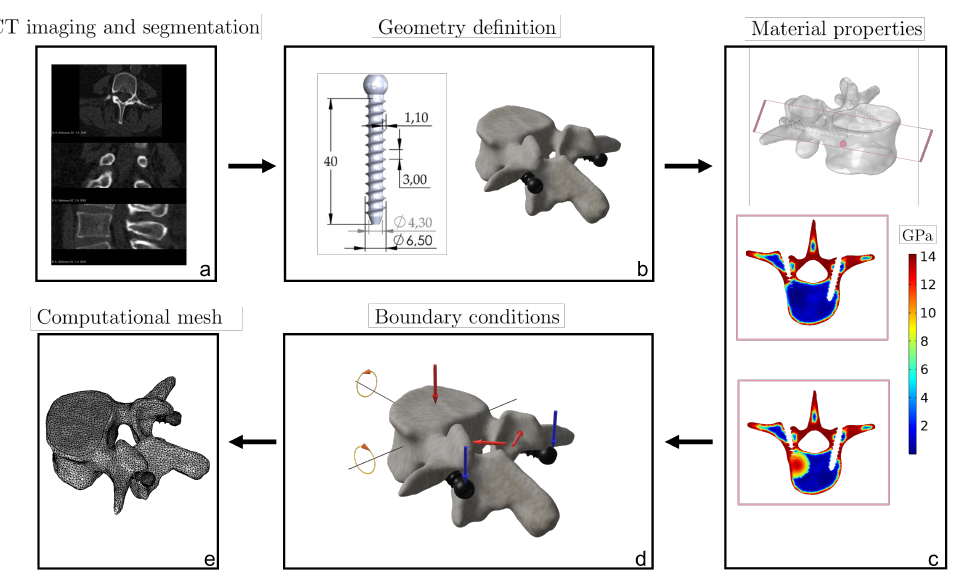
Figure 1. CT-based FE modeling procedure. Starting from CT scan ( a ), the vertebra geometry is reconstructed through segmentation ( b ). In addition, the CAD models of two pedicle screws are designed and virtually inserted in the vertebra ( b ). Then, a simulated metastasis with a spherical shape is included in the model, and it is assumed that the metastatic lesion induces an alteration of Young’s modulus in the bone region close to the metastasis ( c ). Appropriate boundary conditions are chosen to replicate realistic scenarios ( d ). Finally, the screws–vertebra model is discretized using ten-nodes tetrahedral elements ( e